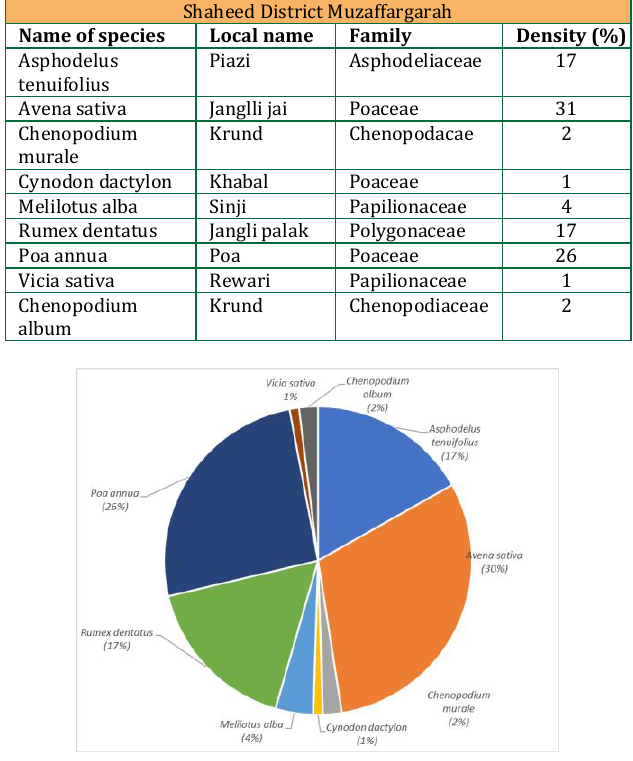
Figure 8: Density (%) of weed infesting wheat field at chok Sarwar Shaheed District Muzaffargarah